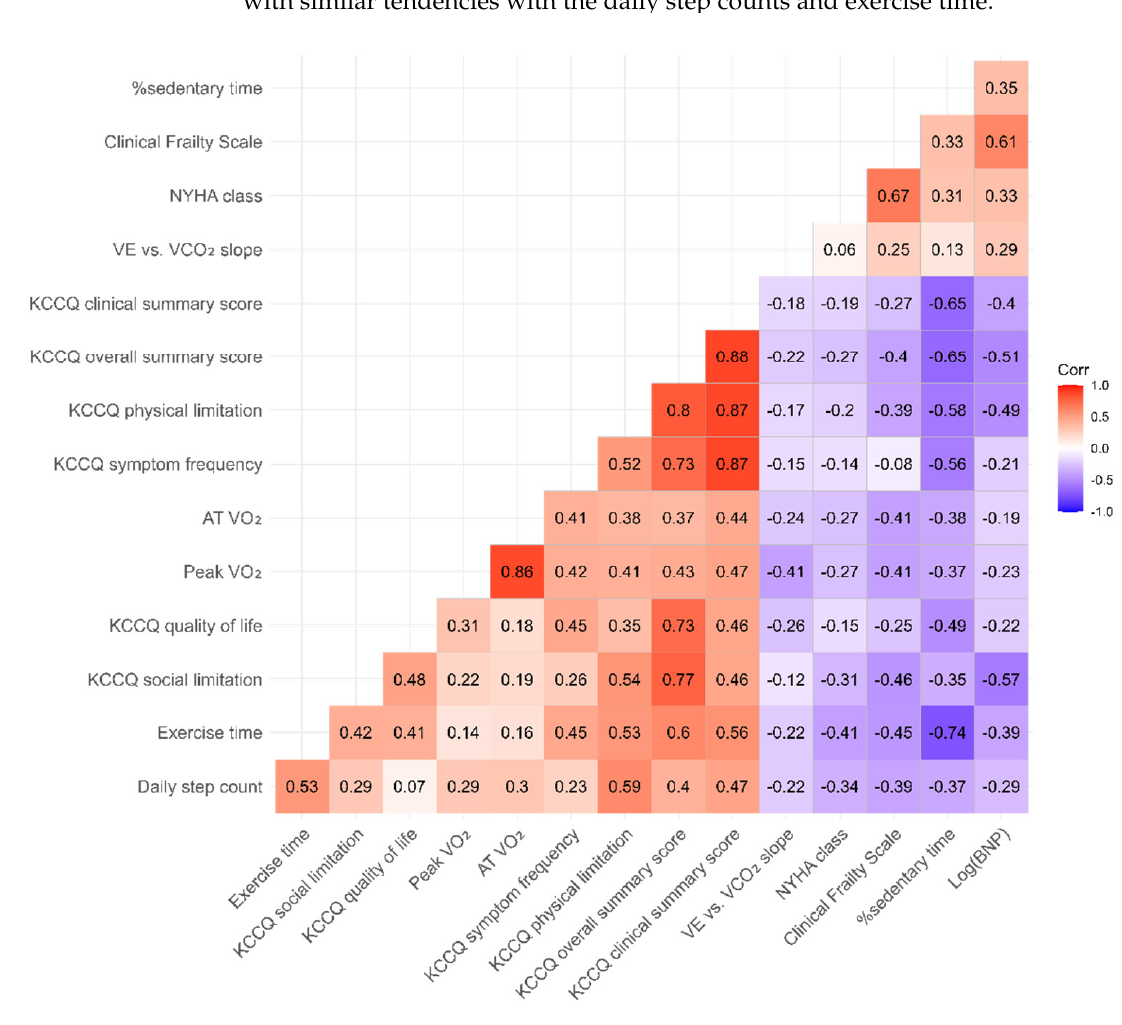
Figure 2. Correlation heatmap of the Kansas City Cardiomyopathy Questionnaire scores, accelerometer-measured parameters, cardiopulmonary exercise testing, BNP, NYHA class, and Clinical Frailty Scale. Values in cells show Pearson correlation coefficients. KCCQ = Kansas City Cardiomyopathy Questionnaire; VO 2 = oxygen consumption; VCO 2 = carbon dioxide production; VE = expiratory minute volume; AT = anaerobic threshold; NYHA = New York Heart Association. Variables were ordered based on hierarchical clustering using hclust in